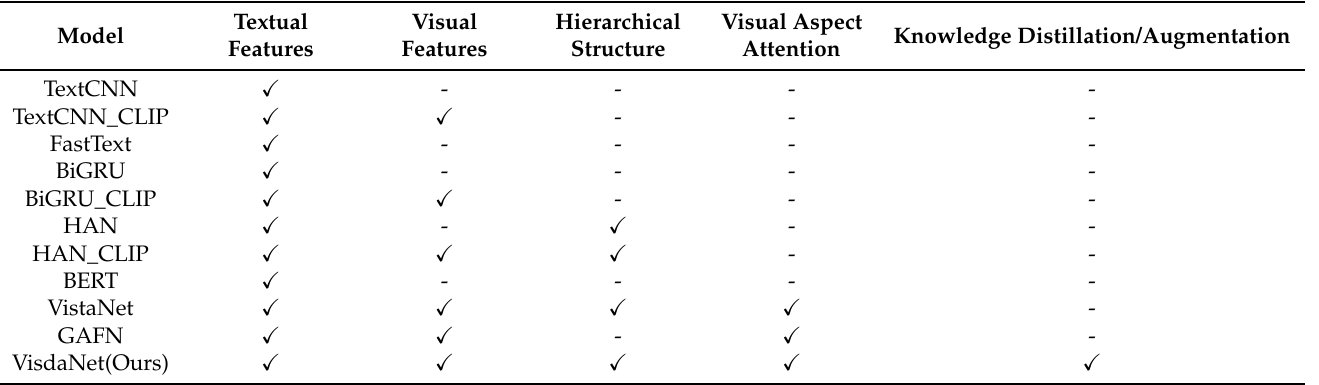
Table 5. Structure comparison to multimodal baselines.